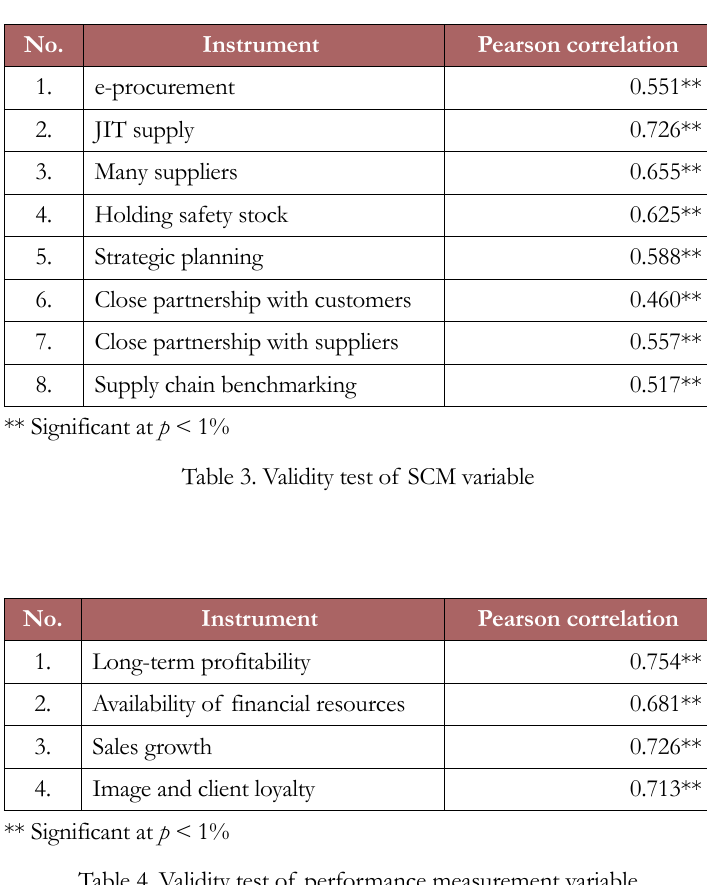
Table 4. Validity test of performance measurement